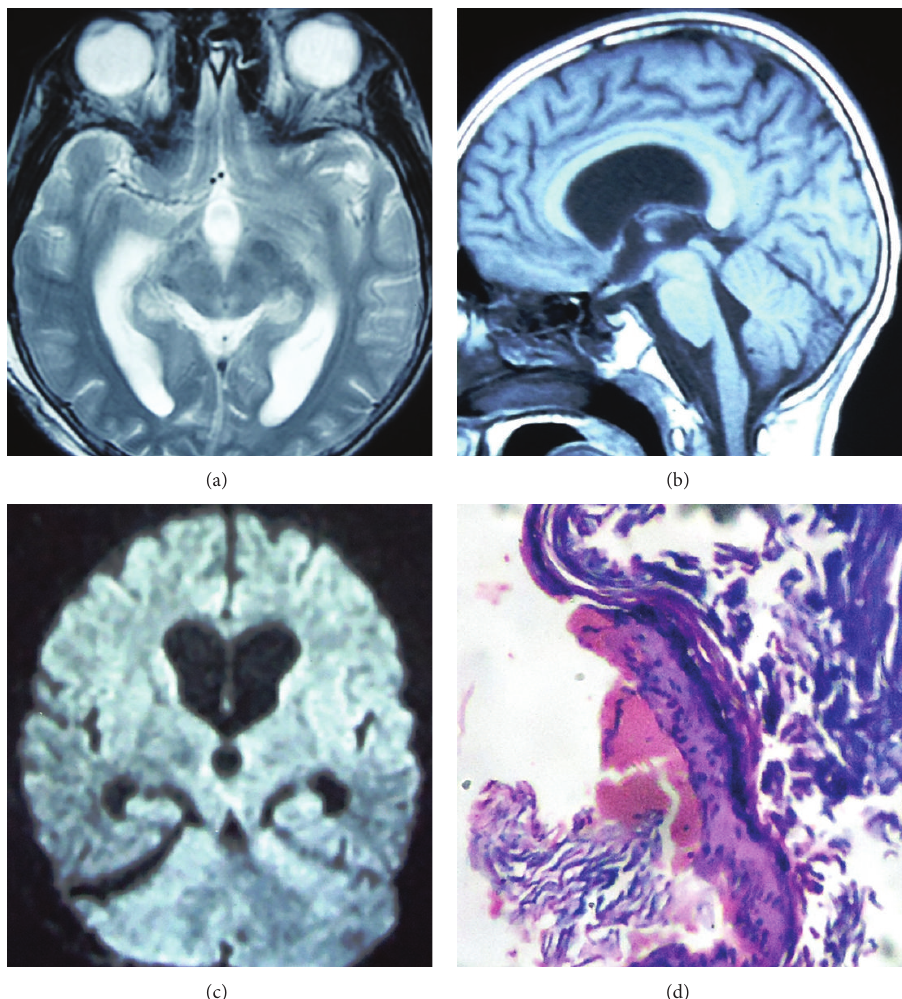
Figure 2: (a) Axial T2, sagittal T1 (b), and diffusion weighted postoperative image (c) showing complete excision of the lesion and resolution of the infarct. (d) The photomicrograph of the lesion (H&E, 100x) showing stratified squamous lining epithelium with lamellated keratin.